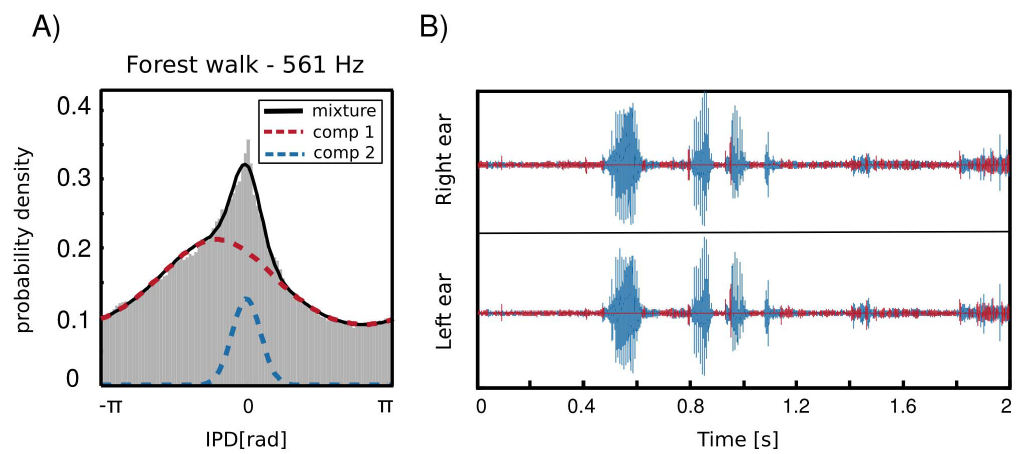
Figure 8. IPD distributions in an auditory scene including self-generated speech. A) An exemplary IPD distribution in the forest walk scene. In addition to a broad ‘‘background’’ component a peak centered at 0 radians is visible. Dashed lines mark components of a fitted von-Mises mixture distribution. B) Results of a sample classification using the fitted mixture model. Intervals were assigned by the algorithm to mixture components of the same color plotted on panel A. Blue intervals include utterances generated by the recording subject.